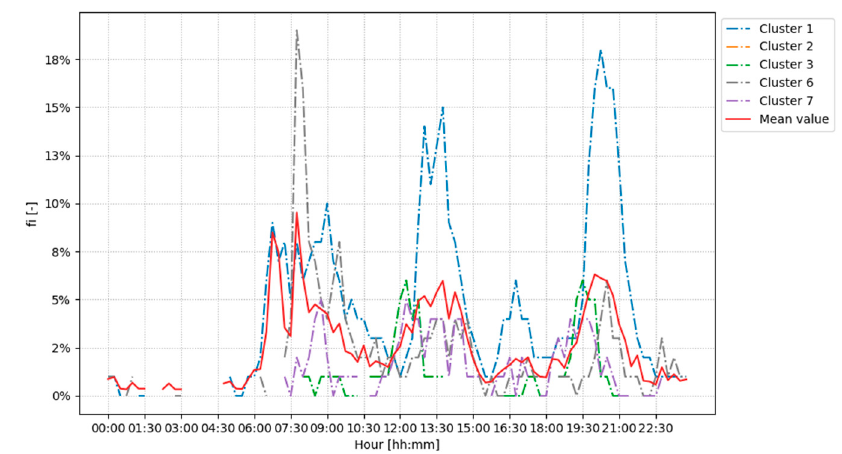
Figure 13. Load profiles of monitored households’ clusters.